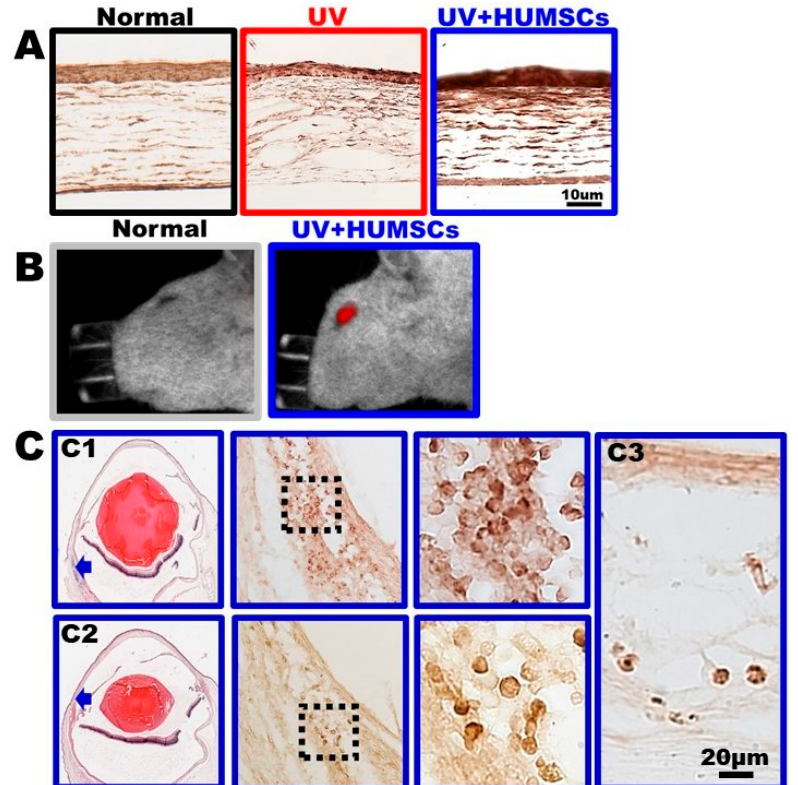
Figure 7. HUMSCs survive and stimulate the expression of ALDH3A1 after UV irradiation. HUMSCs were transplanted into the subconjunctival space of rats after UV irradiation. At 21 days after transplantation, the increased expression of ALDH3A1 was detected in all corneal tissues of the UV + HUMSC group by immunohistochemical staining ( A ). The images show strong red signals after the injection of DiR-HUMSCs in the in vivo fluorescence images ( B ). Sections were stained with hematoxylin and antibody against human nuclei antibody to label the HUMSCs. From low to high magnification, numerous HUMSCs were scattered in the subconjunctival space (arrow) of the UV + HUMSC group ( C ( C1 , C2 )), and a small number of HUMSCs were observed in the stroma of the cornea ( C3 ).